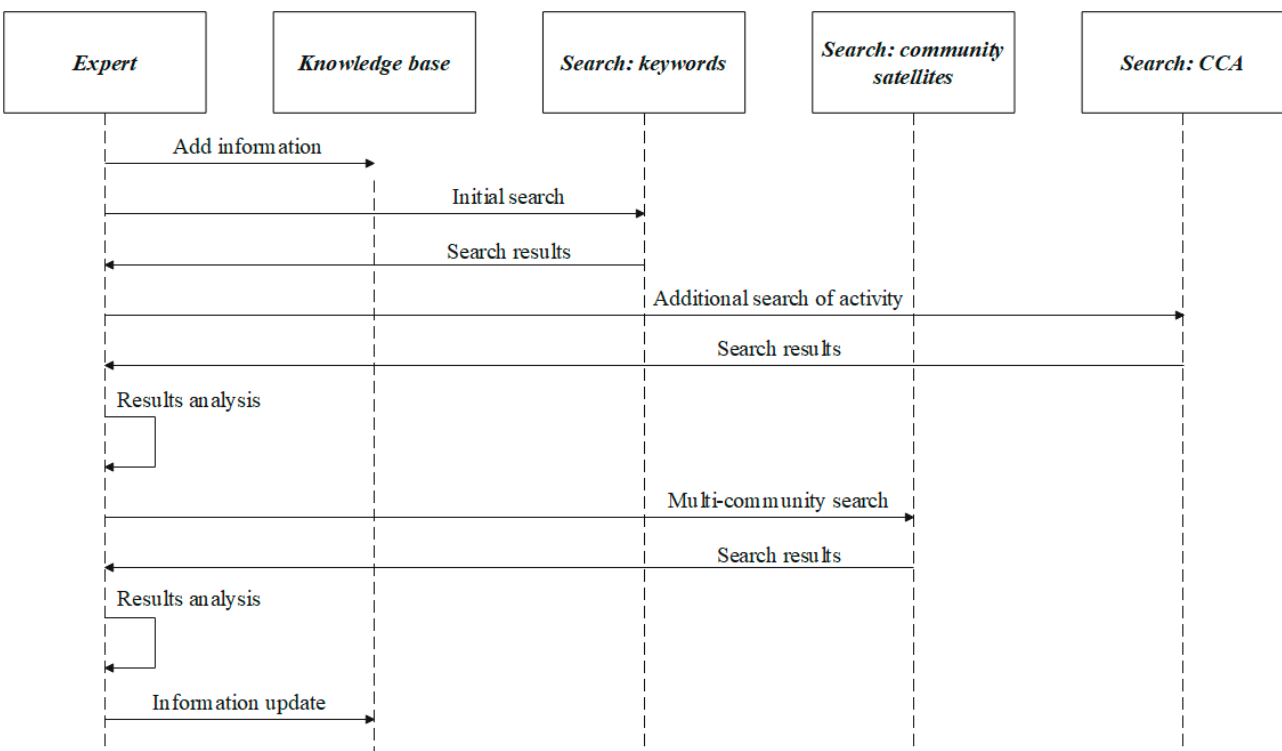
Figure 5. Sequence diagram of the generalized algorithm for detecting active far-right ideological platforms in social media and information influence from the far-right ideological platform.